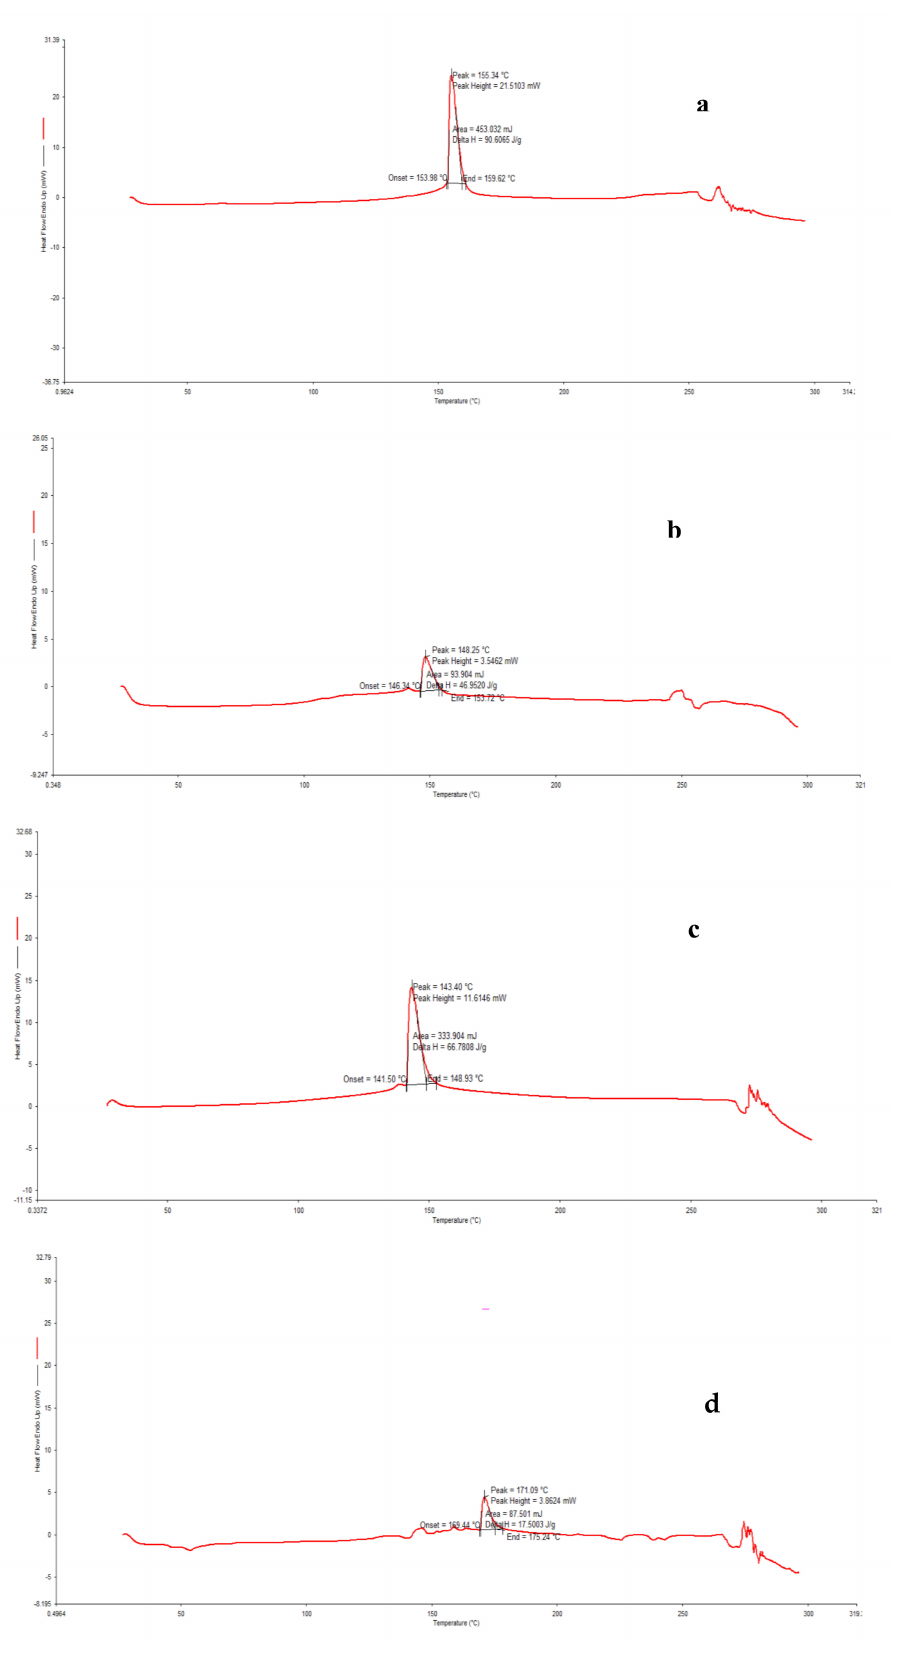
Figure 7. DSC thermograms of maltodextrin ( a ), freeze-dried ( b ), spray-dried ( c ), and microwave-dried ( d )